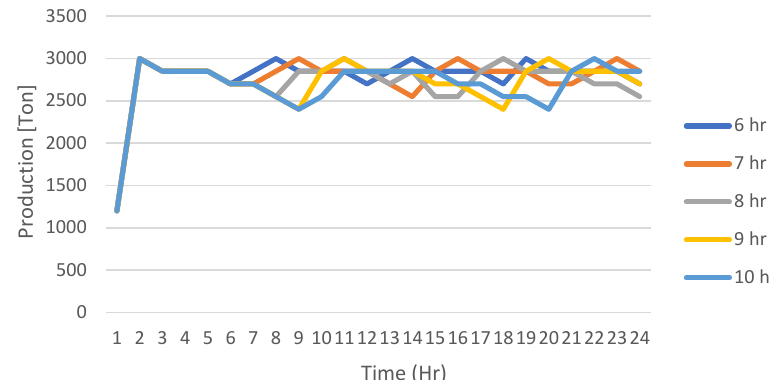
Figure A2. Case study evaluated with medium frequency.